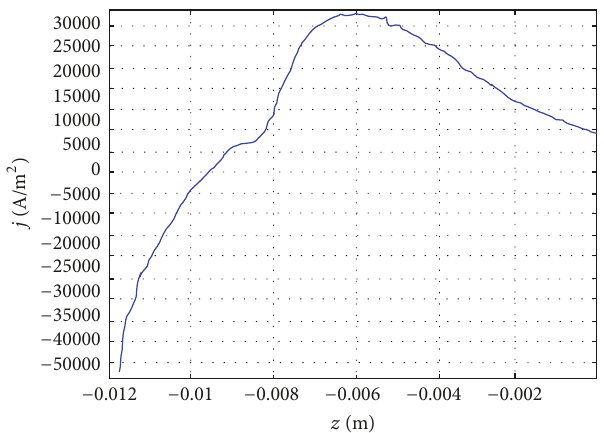
Figure 3: Resulting distribution of the current density on the walls of the penetration